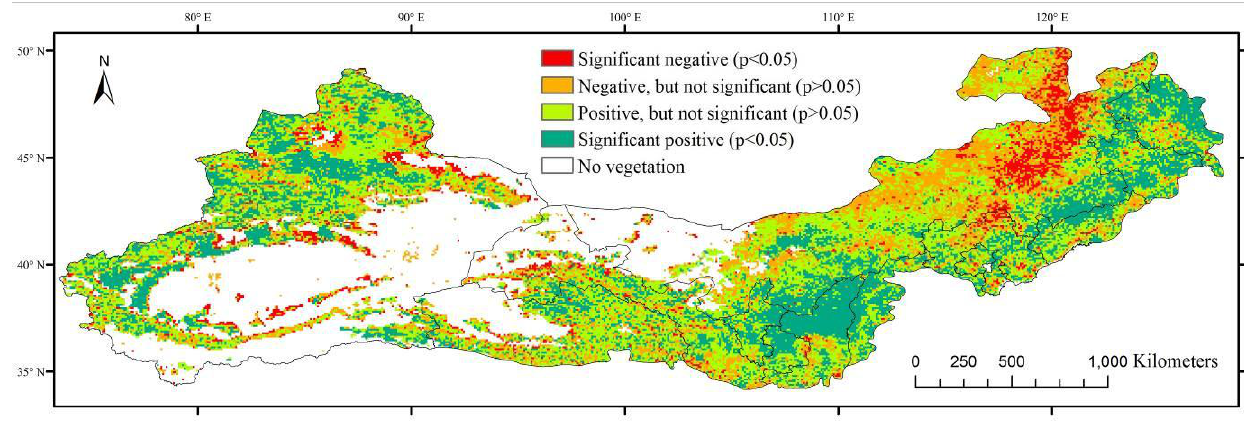
Figure 2. Spatial distribution of changes in growing-season NDVI (Normalized Difference Vegetation Index) from 1982 to 2011. Red areas represent decreasing trends, and green areas represent increasing